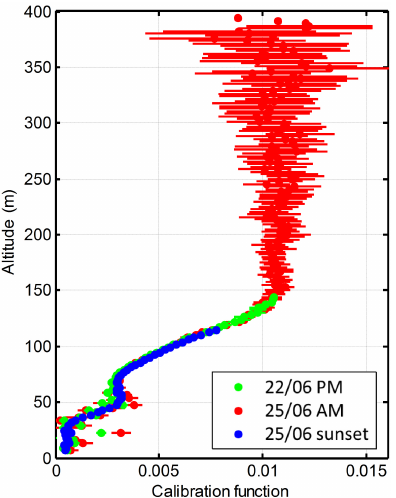
Figure 3. Results of lidar calibration by kite-carried PTU, in terms (z)/K WVMR (dots) as mea- of calibration function C(z) = ξ H 2 O sured during three separate flights: on 22 June afternoon up to 140m, on 25 June morning up to 390m and on 25 June at sun- set up to 115m, the latter providing less noisy estimations of the overlap function at low altitude. The RMSE combining lidar signal noise and sounding errors is shown as horizontal bars. The assessed K WVMR is 95 ± 2gkg − 1